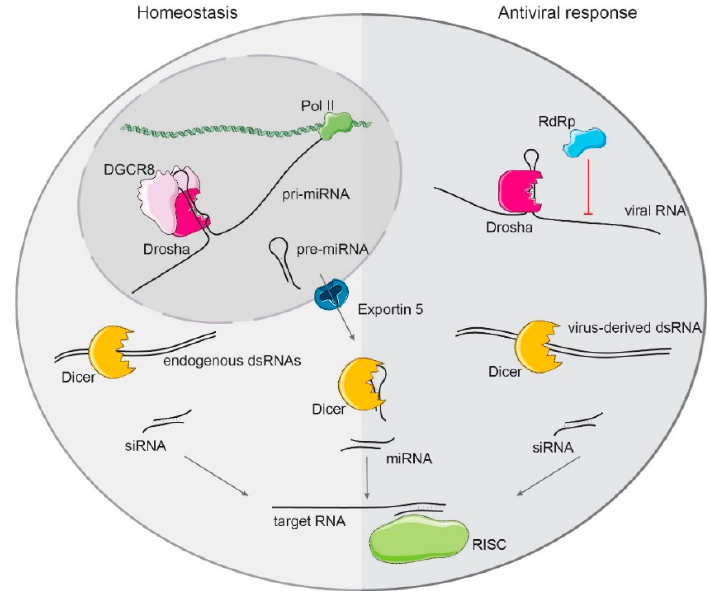
Figure 2. Primary miRNA (pri-miRNA) precursors are transcribed by RNA-polymerase II, and processed in the nucleus by the microprocessor complex, composed by DGCR8 and Drosha. The released hairpin (pre-miRNA) is exported to the cytoplasm by Exportin-5 to be further processed by Dicer to form mature miRNAs that are loaded into the RISC complex to target complementary mRNAs. Both Drosha and Dicer are also antiviral factors. Drosha binding to RNA secondary structures in the viral genomes blocks the viral RNA-dependent RNA-polymerase and replication of the virus. Dicer can cleave the virus-derived dsRNA intermediates of replication to generate small interfering RNAs (siRNAs) that target and induce the decay of viral RNA molecules.